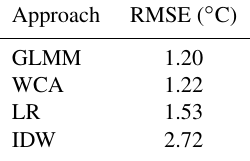
Table 2. Categorical statistics used to assess the capacity of the in- terpolation approaches to predict the occurrence of precipitation. Precipitation Observed Not observed